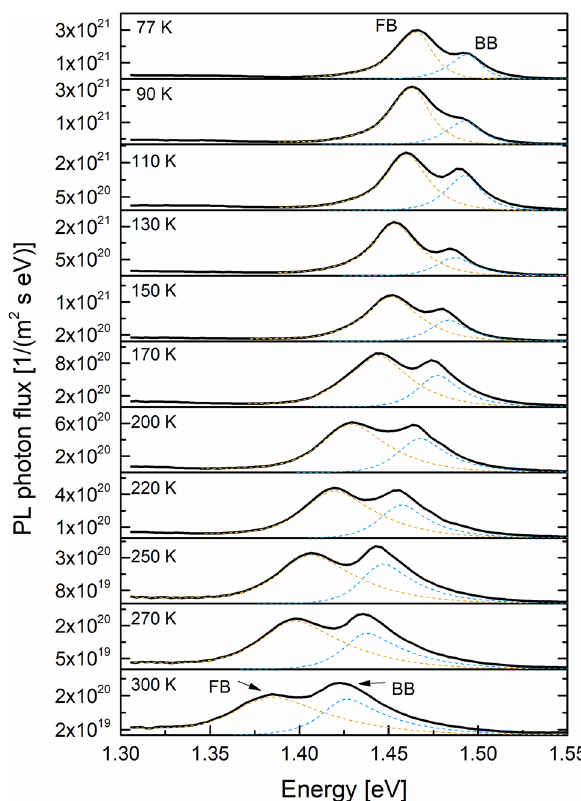
Figure 6. The absolute PL photon flux at several temperatures from the location marked as “spot 1” in Fig. 3. The dashed orange and blue lines are the deconvoluted FB and BB individual